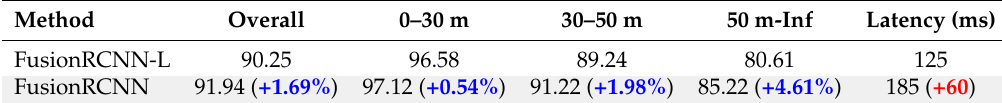
Figure 6. Framework comparison of FusionRCNN and FusionRCNN-L. FusionRCNN-L is a LiDAR- based method that disables intra-modality self-attention of the image branch and inter-modality cross- attention module in Fusion Encoder. Table 6. Vehicle BEV detection under different distance on Waymo validation set. FusionRCNN- L donates the LiDAR-based two-stage method by disabling the image branch. The performance improvements and latency increase are painted in blue and red